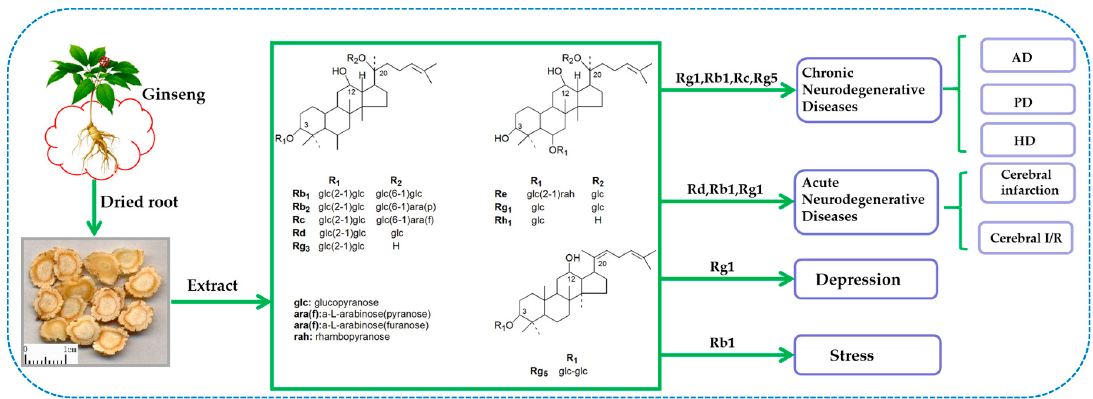
Figure 2. The review’s profiling for neuroprotective effects of ginseng phytochemicals.